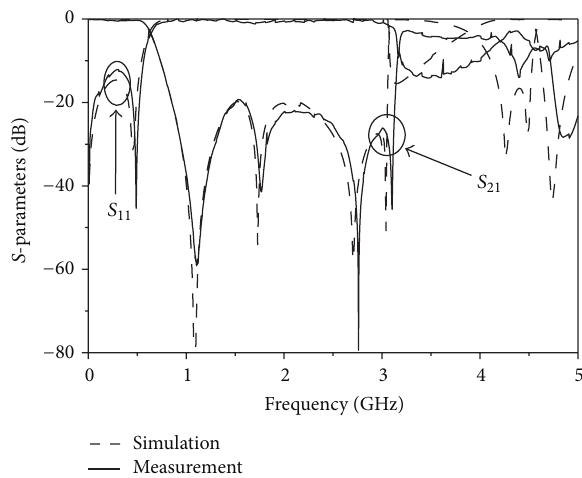
Figure 7: Simulated and measured frequency responses of the fabricated